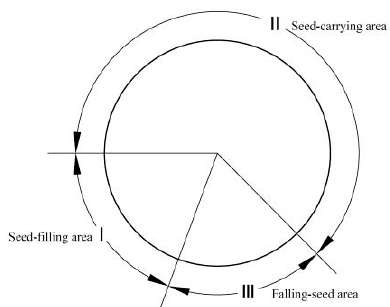
Figure 2. Zone Ⅰ : seed-filling zone; Zone Ⅱ : seed-carrying zone; Zone Ⅲ : seed-dropping zone.